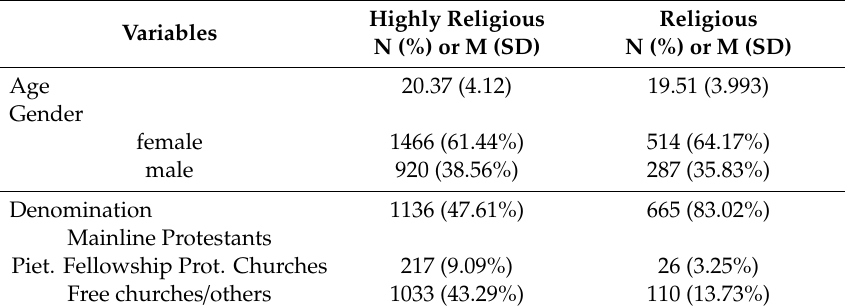
Table 1. Descriptive statistics of the